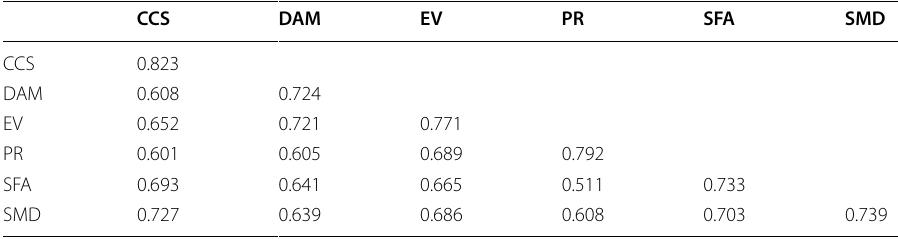
Table 4 Discriminant